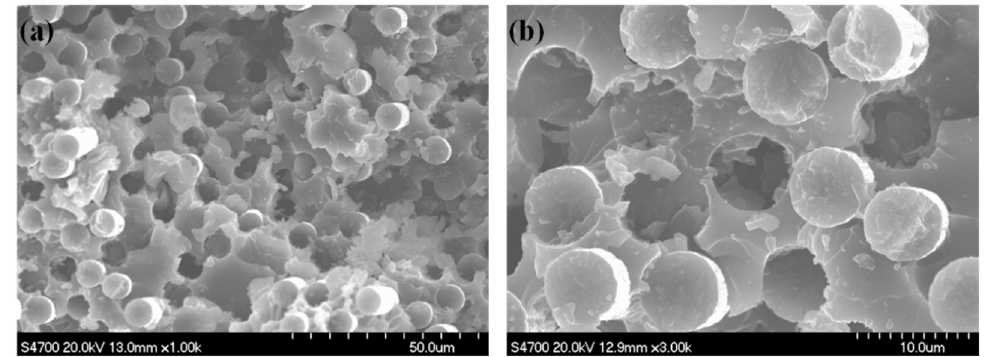
Figure 6. SEM images of the AMGNS-MWCNT/CFEP unidirectional composites: ( a ) low-magnification micrograph of the fiber and surrounding matrix; ( b ) high-magnification view of the fiber/matrix interface.